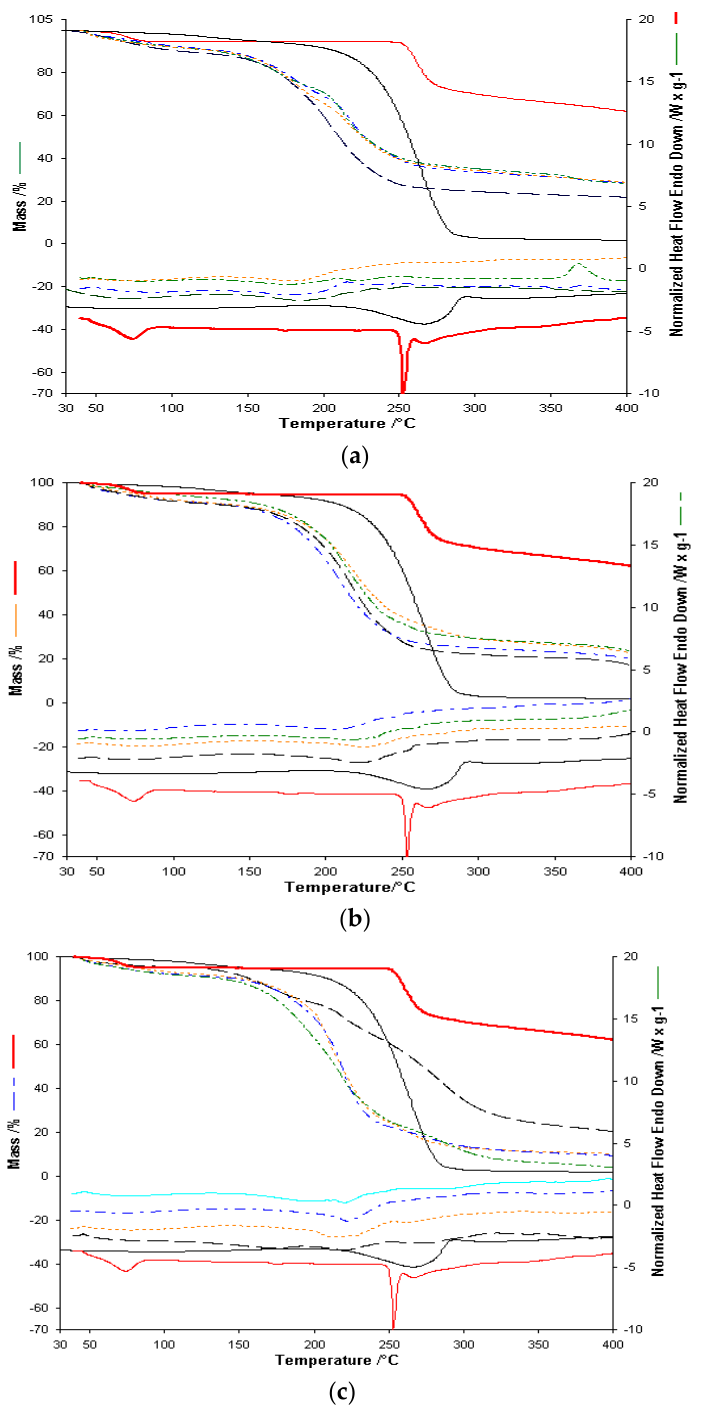
Figure 7. ( a ). Comparative of TGA and HF for Av(D)___, L(D) ___, AG_ _, AG_Av…., AGL_ ._ ., AGLAv .. _ .. _.; ( b ). Comparative of TGA and HF for Av(D) ___, L(D) ___, AGP - - -, AGP_Av…., AGPL_ ._ , AGPLAv .. _ .; ( c ) . Comparative of TGA and HF for Av(D)____, L(D) __, AGPV - - -, AGPV_Av……., AGPVL_ ._ , AGPVLAv .. _ ...